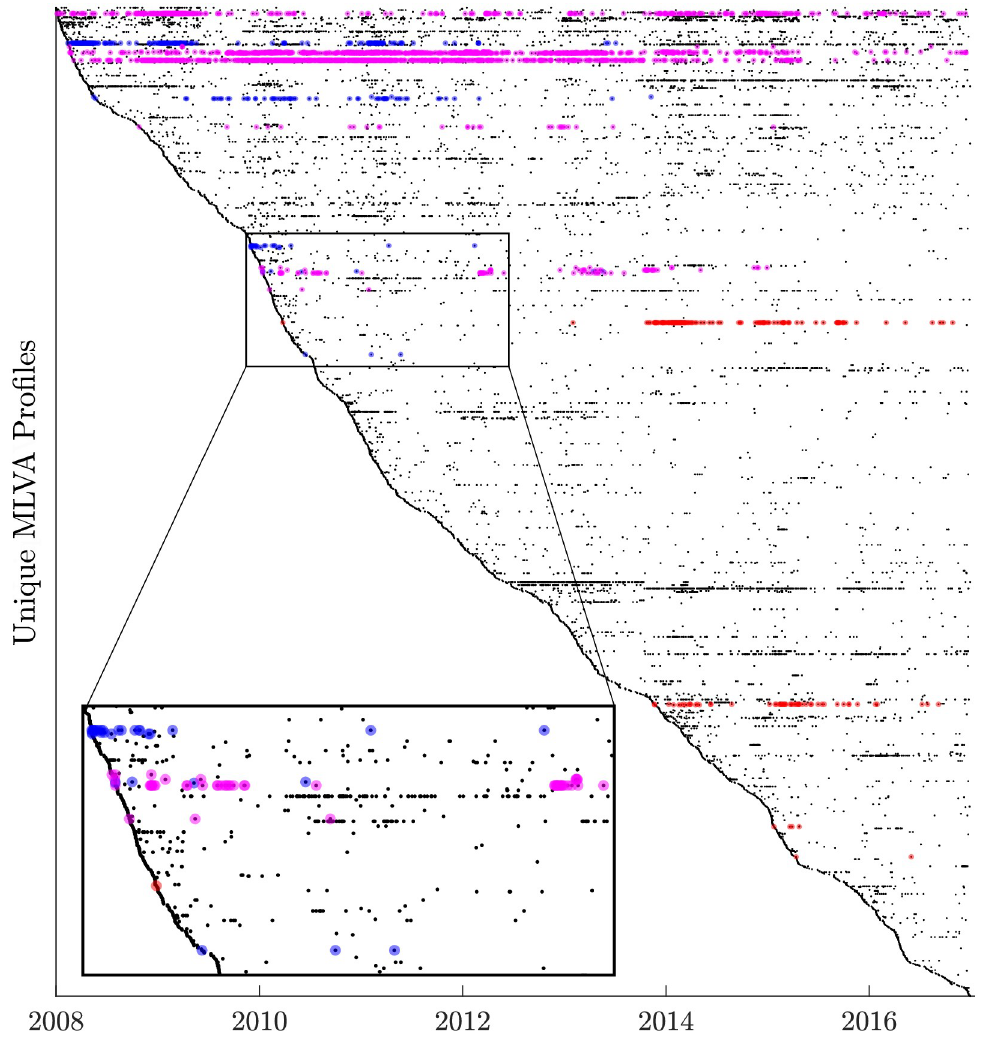
Fig 1. The 1,673 unique MLVA profiles isolated between 1 January 2008 and 31 December 2016. Each horizontal line shows the temporal history of a given MLVA profile, with each point showing the day a sample was collected. The dataset contains 17,005 cases of STM, which comprises 98.7% of all isolated cases in NSW over this 3,287 day period. The profiles are sorted according to the date of their first detection—resulting in a diagonal outline—indicating that new MLVA profiles are usually detected regularly throughout the observational period. Once detected, the profiles typically continue to be observed in the dataset. Three actual case studies associated with outbreaks previously investigated by the Australian Department of Health (see Materials and methods) are highlighted in different colors, illustrating distinct MLVA profiles that are grouped according to their genetic and temporal proximity (that is, profiles with the same color lie on the same inferred evolutionary